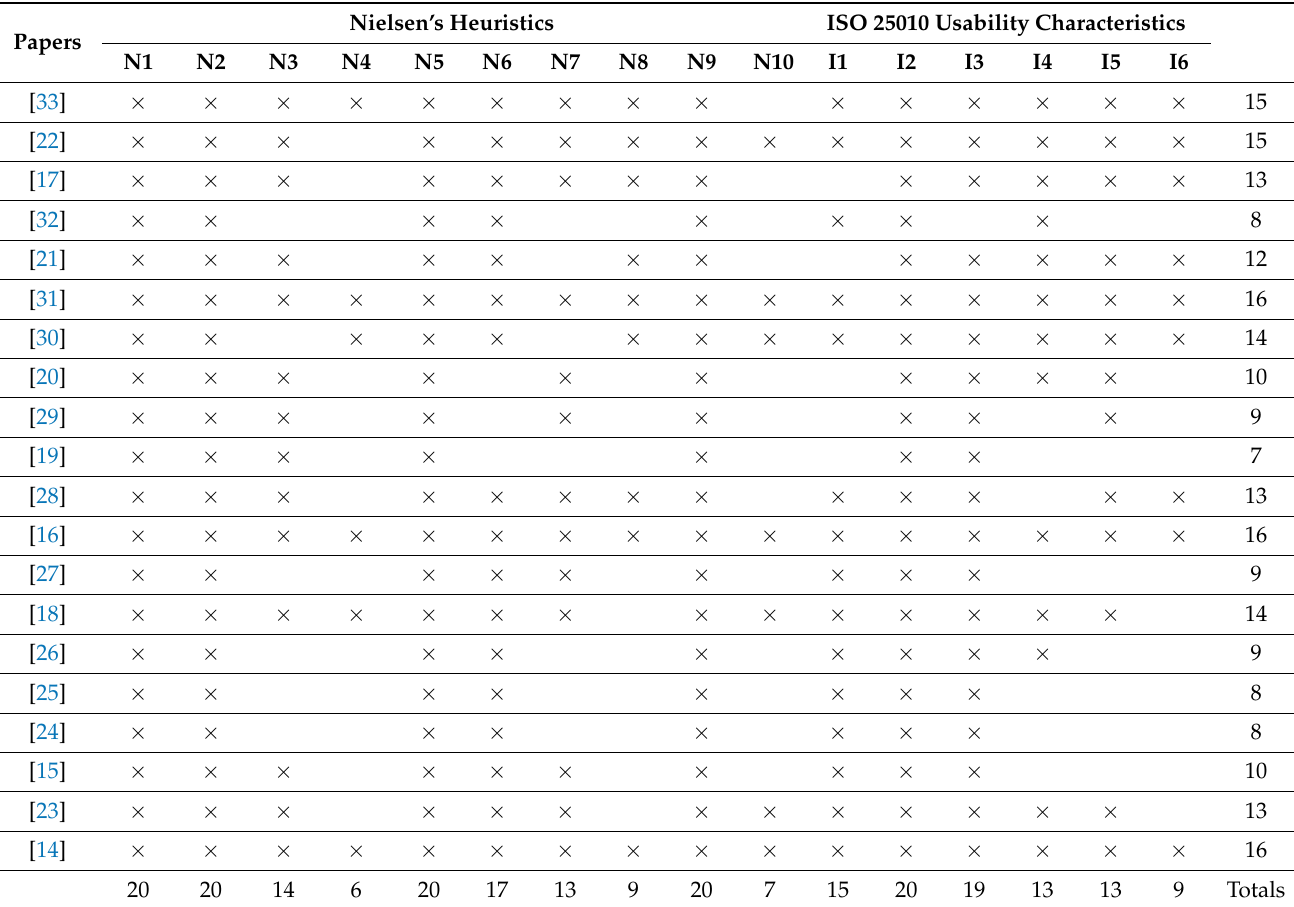
Table 6 reveals a relationship between Nielsen heuristics, ISO 25010 usability character- istics and all 20 of the selected publications that helps to better understand the importance of these aspects to the different authors. One usability characteristic and four heuristics have dependencies with all of the publications, namely: N1-visibility of system status; N2-match between system and the real world; N5-error prevention; N9-helping users recognize, diagnose, and recover from errors; I2-learnability. On the other hand, three heuristics and one usability characteristic could only be mapped to less than half of all of the selected publications. Those were heuristics N4-consistency and standards ( n = 6), N8-aesthetic and minimalist design ( n = 9), N10-help and documentation ( n = 7) and the usability characteristic I6-user interface aesthetics ( n = 9). Additionally, it is noteworthy that only three publications have outlined recommendations related to all of the usability heuristics and characteristics. Table 6. Mapping (denoted by × ) between selected papers and selected usability recommenda- tions’